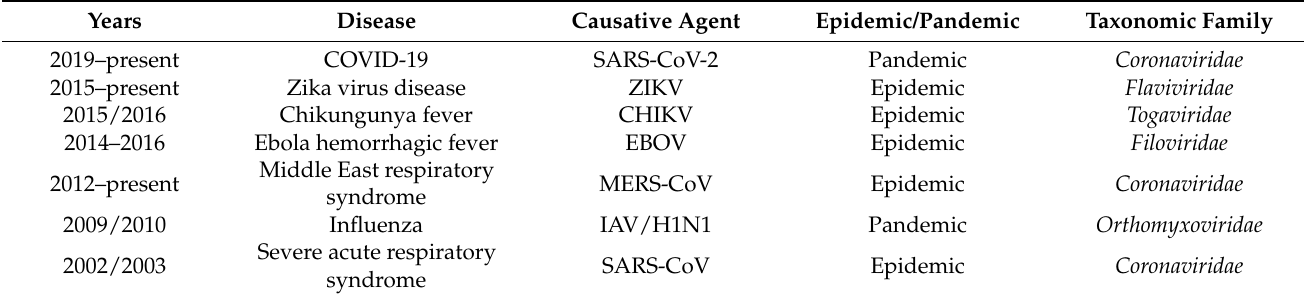
Table 1. Major epidemics and pandemics of zoonotic origin since 2000 (Source: WHO). Abbreviations: COVID-19— coronavirus disease 2019; SARS-CoV-2—severe acute respiratory syndrome coronavirus 2; ZIKV—Zika virus; CHIKV— Chikungunya virus; EBOV—Ebola virus; IAV/H1N1—influenza A virus subtype